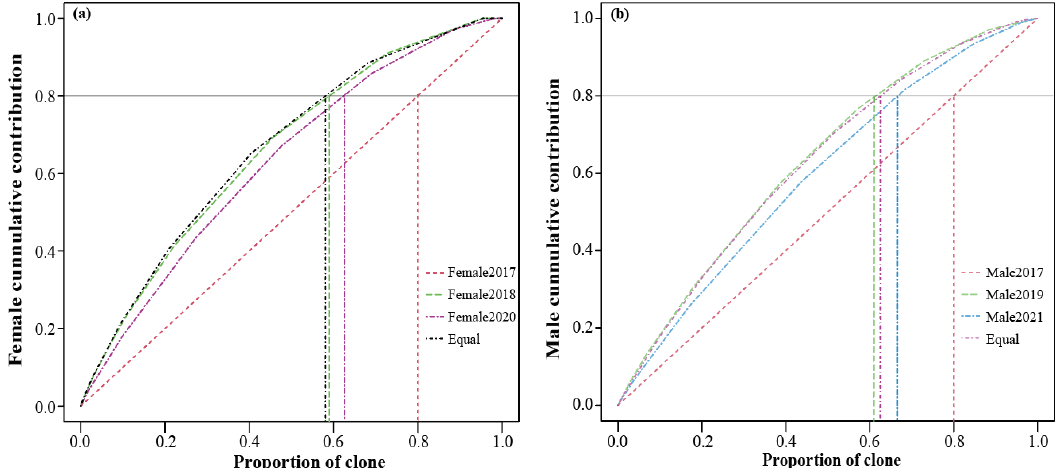
Figure 2. Female ( a ) and male ( b ) P. orientalis clonal cumulative contribution curves across years. 3.3. Fertility Variation, Effective Population Size, and Genetic Diversity Fertility variation of male and female parents varied slightly among years (Table